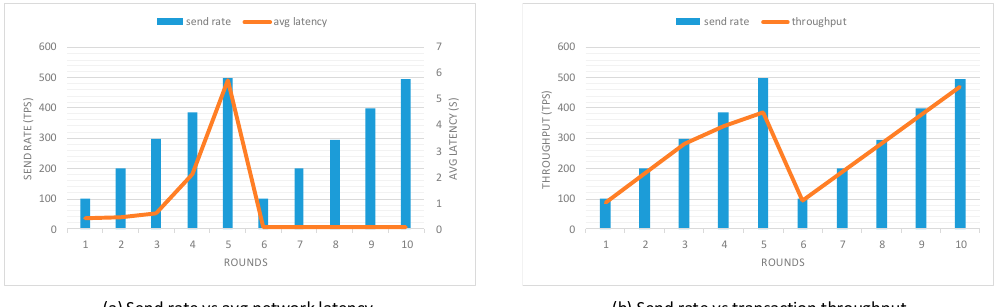
Figure 9. Performance evaluation with the 3-organization-2-peer network model.